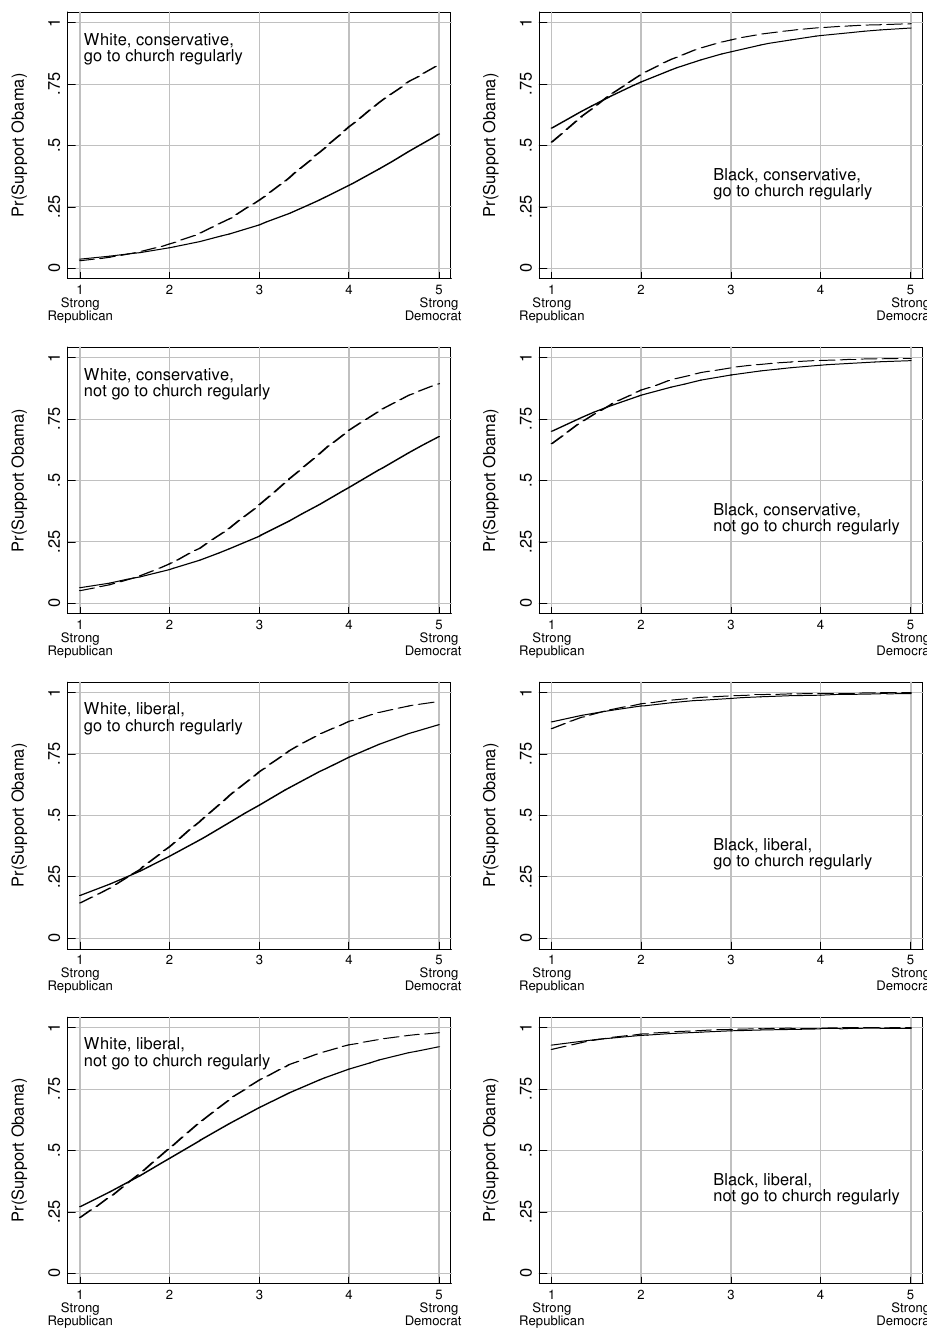
Figure 2. Effects of Biracial Perception on Support for Obama by Party Affiliations Figure 2: Effects of Biracial Perception on Support for Obama by Party Affiliations. Time Magazine Data Source.— Time Magazine Poll # 2008-4556, September 26-29, 2008. Poll - 2008-4556, September 26-29, 2008. Probabilities are based on Model 4 in Table 2. All other variables are held at means. Dashed line: Biracial perception; Solid line: No biracial perception.